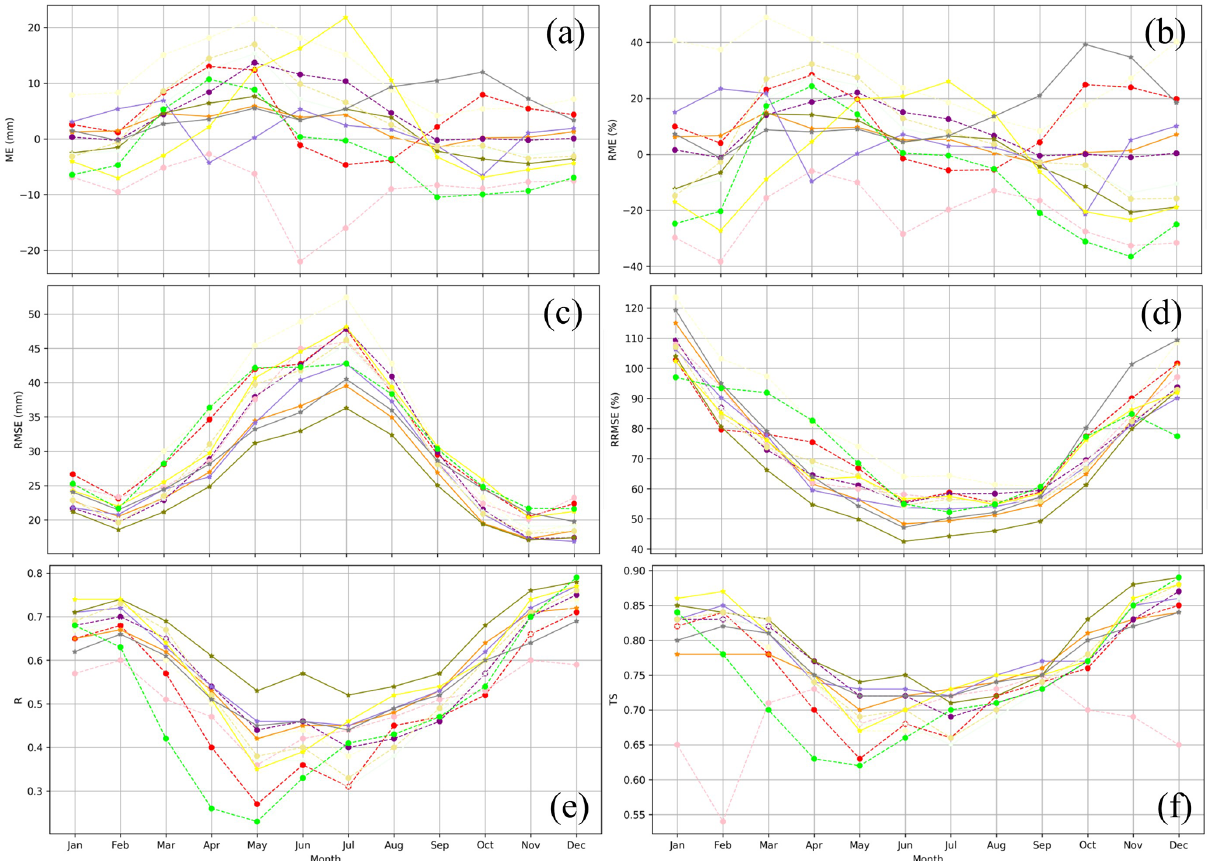
Figure 5. Monthly validation metrics – ME (mm): ( a ); RME (%): ( b ); RMSE (mm): ( c ); RRMSE (%): ( d ); R : ( e ); TS: ( f ) – of ET products against flux EC ET for all sites (legend as Fig.